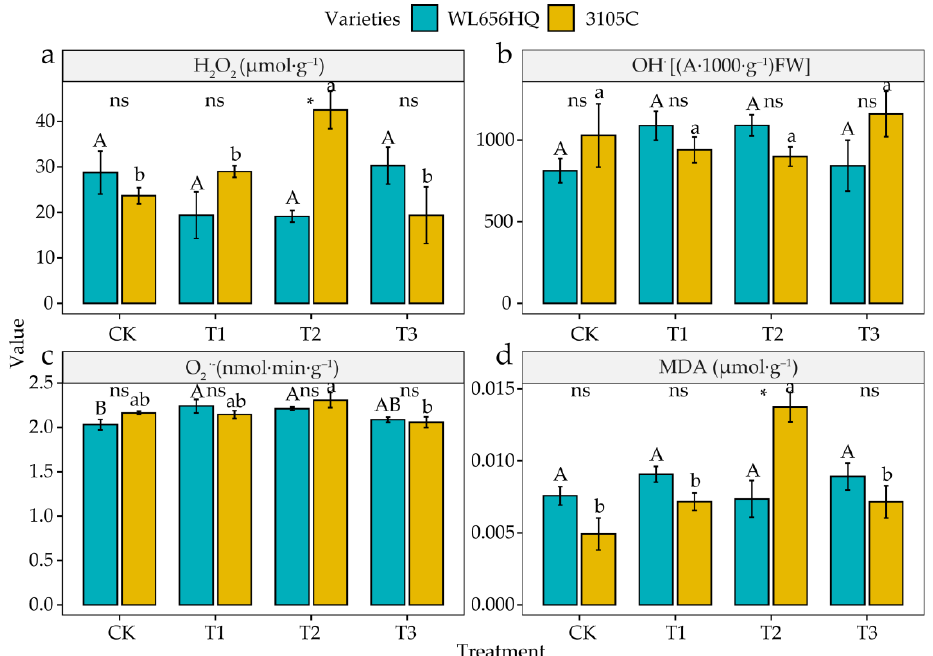
Figure 6. Effects of autotoxicity on hydrogen peroxide, hydrogen radical, superoxide anion radical and malondialdehyde content of alfalfa. The blue in the box plot represents the variety WL656HQ; the yellow represents the variety 3105C. The different lowercase and uppercase letters represent the significance of 3105C and WL656HQ at different concentrations. * Indicates the difference between the two varieties. The value p ≤ 0.05 is marked as *. The value p > 0.05 is marked as ns. ( a ) H 2 O